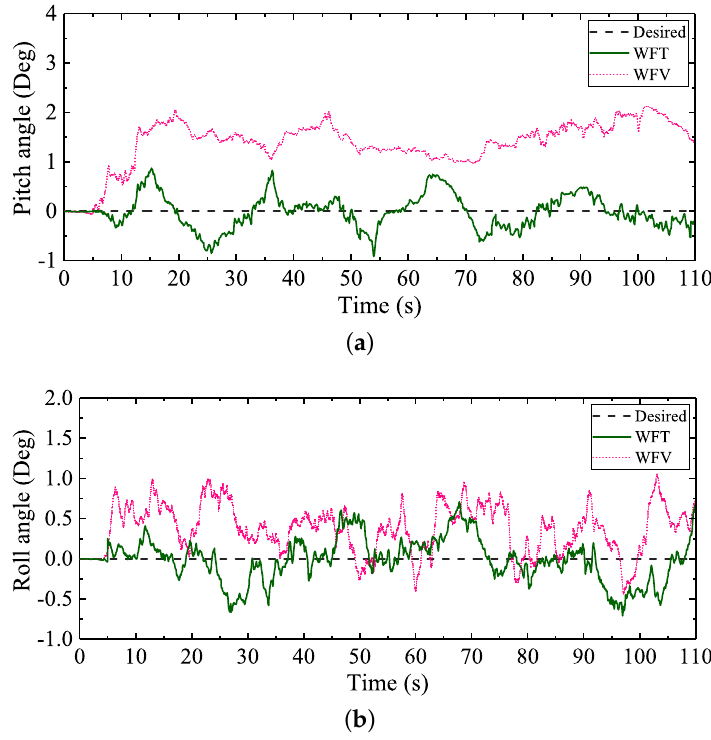
Figure 17. The attitude regulation performances of the pitch and roll angles under WFT and WFV: ( a ) the body pitch angle comparison and ( b ) the body roll angle